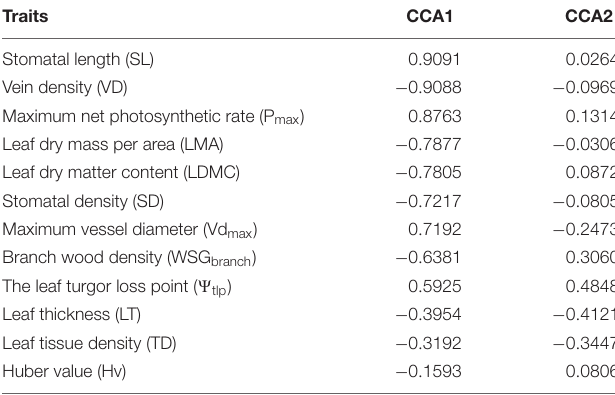
TABLE 3 | Loadings of measured traits to CCA1 and